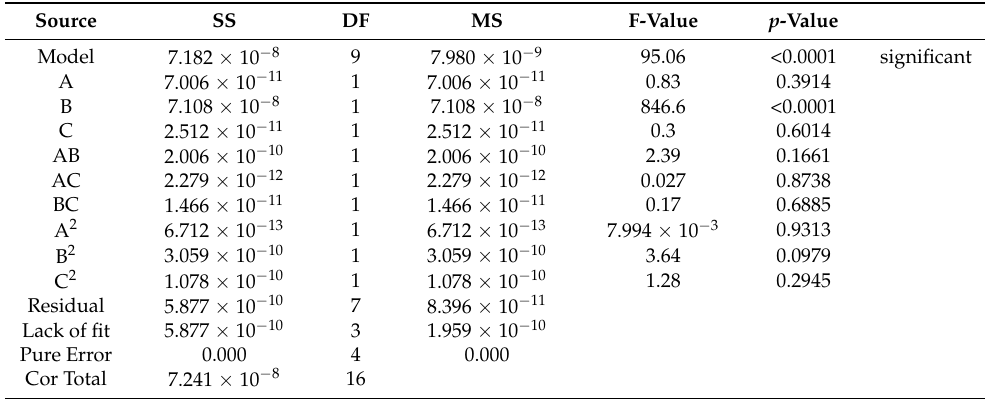
Table 5. Variance analysis of wear depth regression